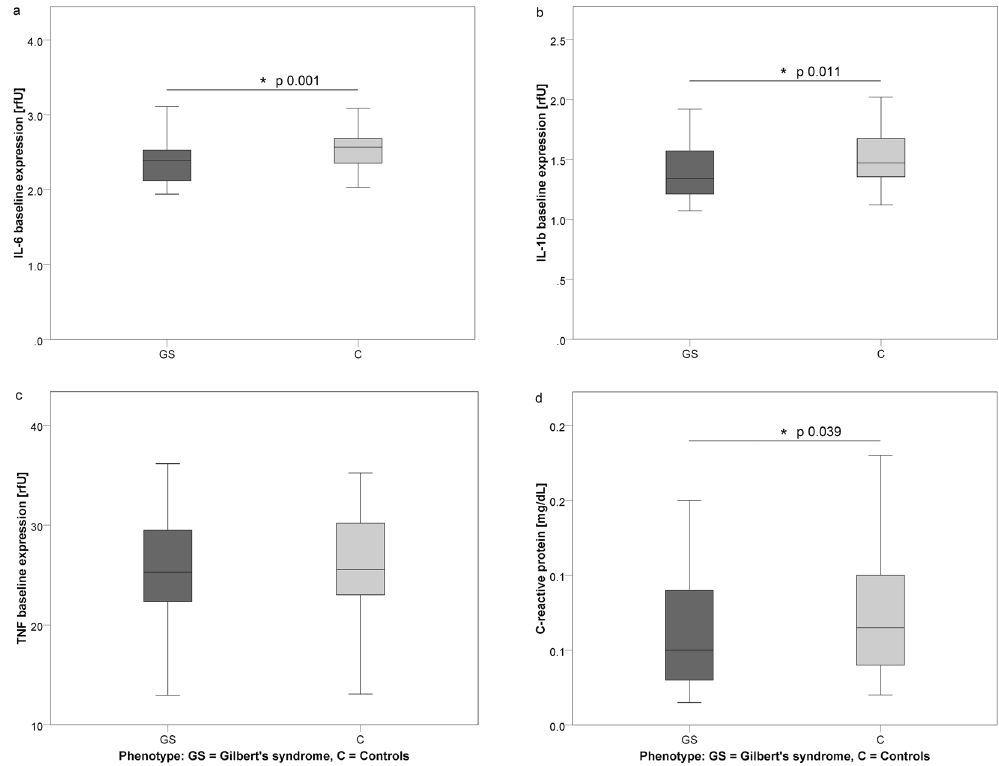
Figure 1. Differences in the inflammatory status between GS and C individuals (all subjects). Figure 1 ( a – d ) illustrates inter-group differences in the inflammatory parameters of intracellular IL-6, IL-1 β , TNF α and circulating CRP (Phenotype: GS: dark grey, C: light grey). Abbreviations: IL-6/IL-1 β : intracellular interleukins 6/1 β ; TNF α : intracellular tumor necrosis factor; CRP: circulatory C-reactive protein; GS: Gilbert’s syndrome; C: control subjects. * Indicates significant difference on a 5% level of